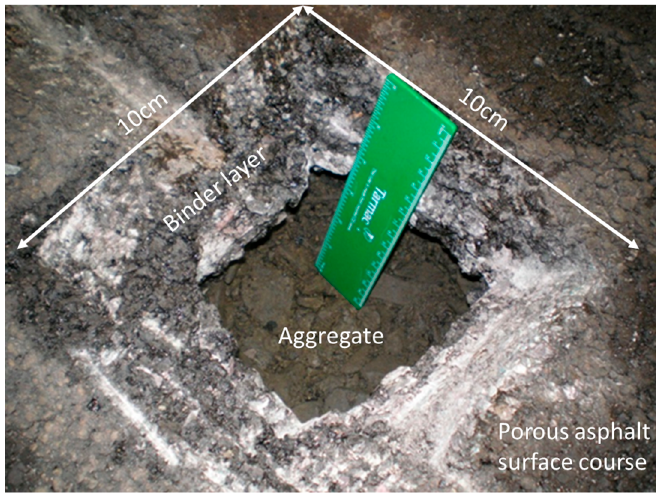
Figure 2. Hole excavated in the surface course of the test rig to enable access to the layers